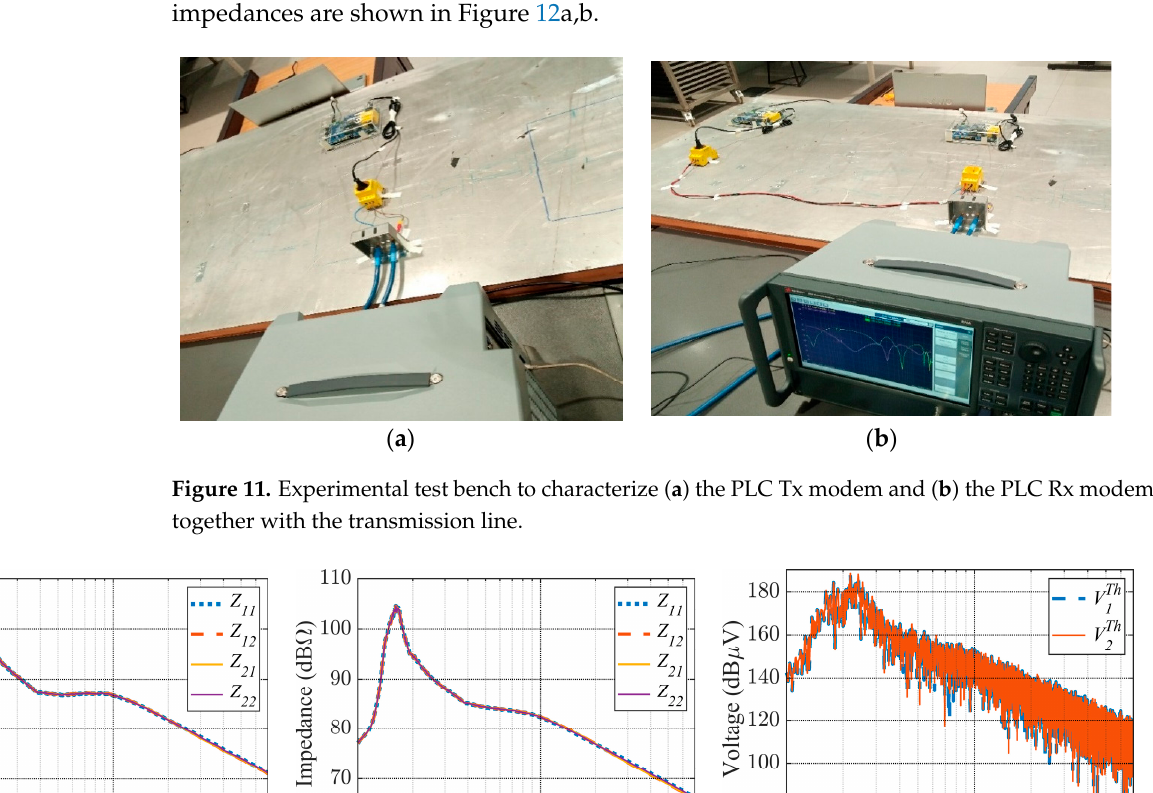
Figure 10. Impedance plots: ( a ) DOG-160G LISN (LISN A), ( b ) LISN B1, and ( c ) LISN B2.